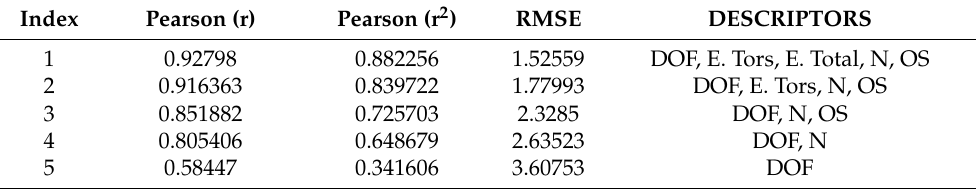
Table 7. Descriptors used in QSAR model for antimicrobial activity against E. coli .